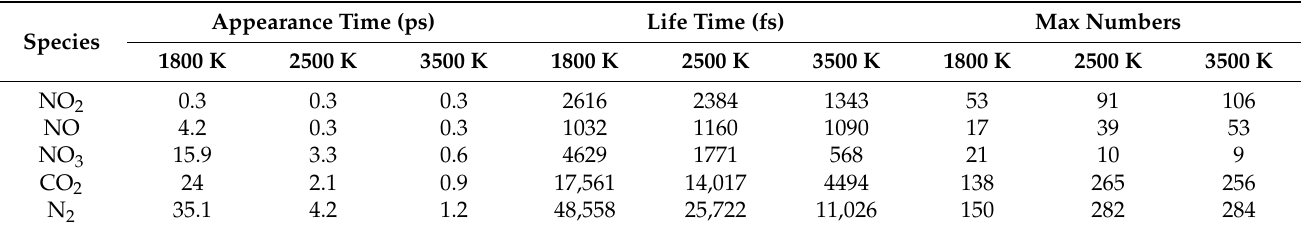
Table 3. Evolution details of various species.